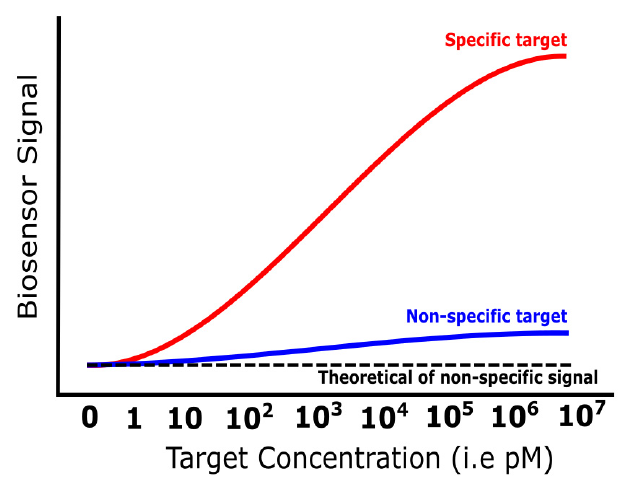
Figure 9. The illustration of the standard curve fitting for the specificity test in biosensors.